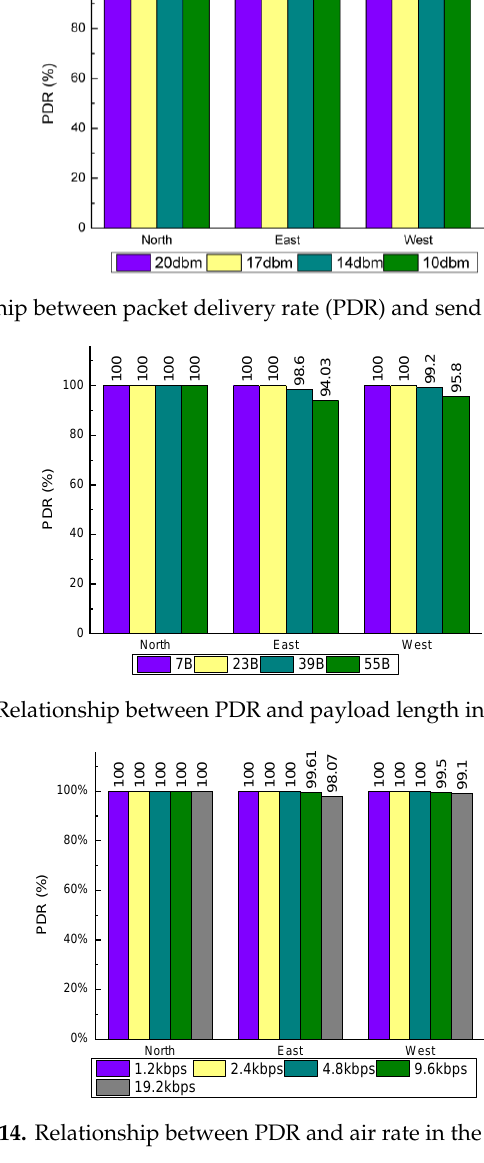
Figure 14. Relationship between PDR and air rate in the same floor.